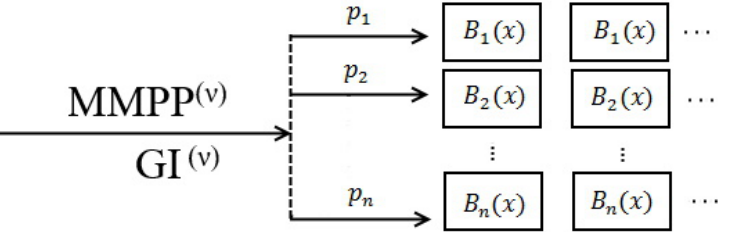
Figure 1. Resource queueing system with n different customer